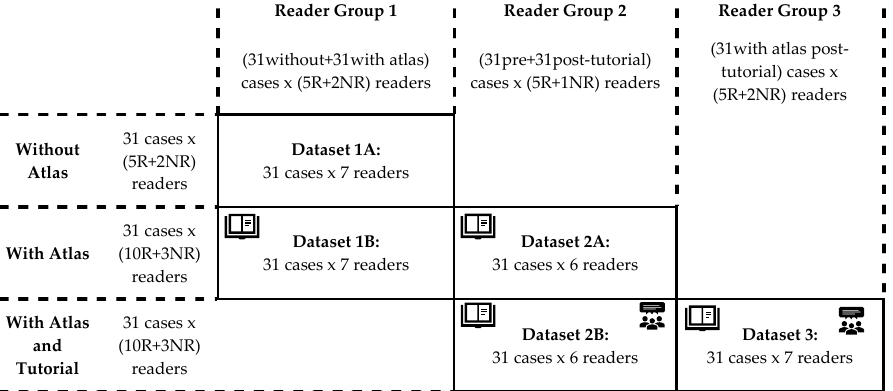
Figure 1. Schematic representation of the composition and methods of the different reader groups. All reader groups in this study used the same set of 31 bilateral temporomandibular joint (TMJ) examinations from patients with diagnosed or suspected juvenile idiopathic arthritis (JIA, clinical characteristics shown on Table 1). Pooling datasets 1B with 2A, and 2B with 3 enables the calculation of inter-reader reliability in larger reader groups and within and between reader specialty groups (results shown on Table 2). Pooling datasets 1A with 1B, and 2A with 2B enables the calculation of intrareader reliability between levels of calibration and inter-reader reliability between and within levels of calibration (results shown on Table 3). Abbreviations: R, radiologist; NR, non-radiologist clinician.